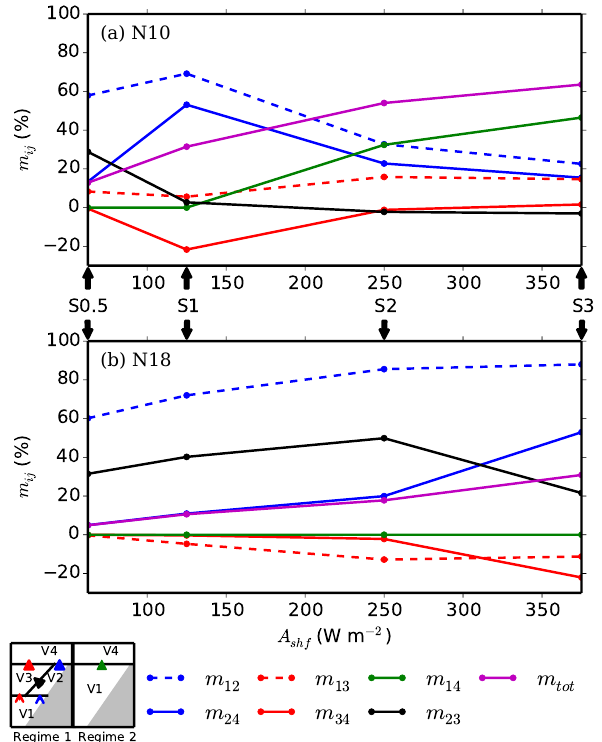
Figure 7. As in Fig. 5, but as a function of the forcing amplitude, A shf , for (a) N10 and (b) N18.